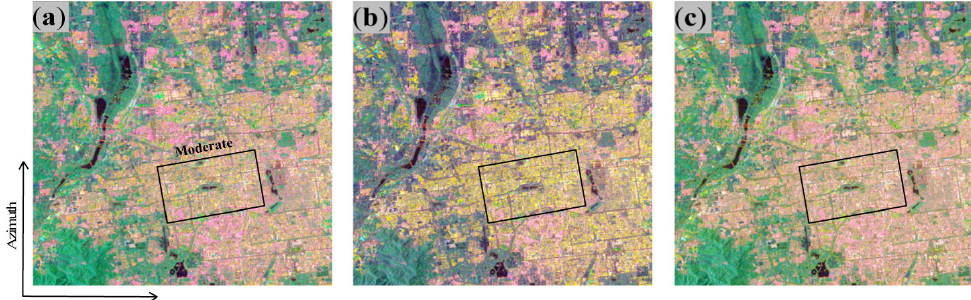
Figure 5. The color-coded images of the decomposition results for the GF-3 dataset (red: double- bounce scattering; green: volume scattering; blue: surface scattering). ( a ) 5XD decomposition method. ( b ) 7SD decomposition method. ( c ) Proposed decomposition method.